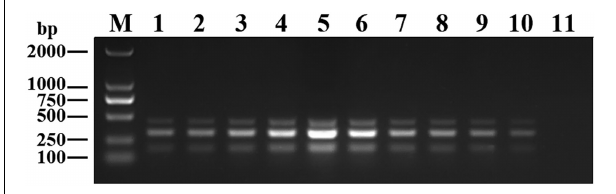
FIGURE 4 | Optimization of GNPs concentration. The volumes of GNPs (10 nM) were tested ranging from 0.1 to 1.0 µ L in increments of 0.1 µ L. Lane M, DL2000 DNA maker; Lane 1–10, 0.1 µ L, 0.2 µ L, 0.3 µ L, 0.4 µ L, 0.5 µ L, 0.6 µ L, 0.7 µ L, 0.8 µ L, 0.9 µ L, and 1.0 µ L, respectively; Lane 11, negative control.